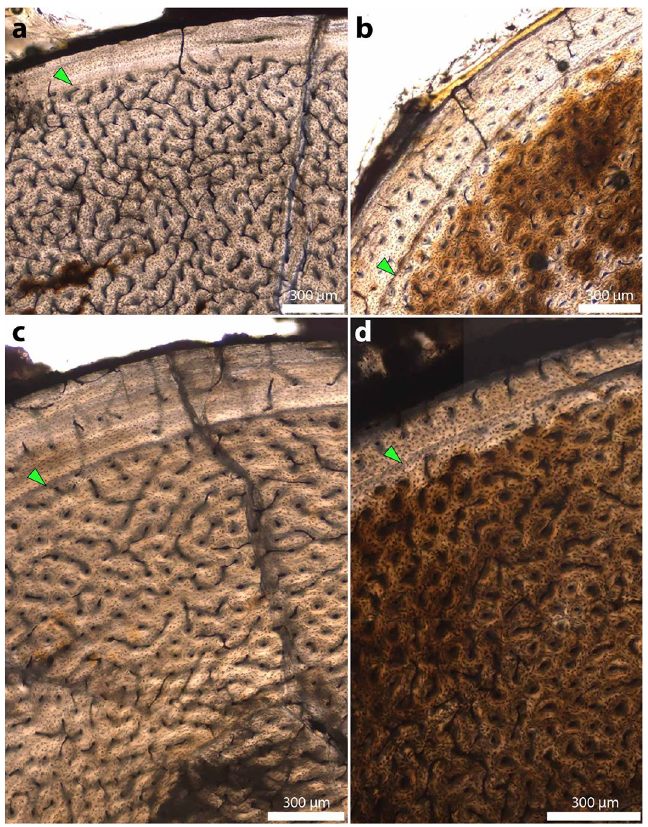
Figure 3. Cortices of Coelophysis bauri tibiae show evidence of slowed growth in individuals from different age classes. ( a ) YPM VP 41197, showing an abrupt transition from woven bone to parallel-fibered or lamellar bone in the outermost cortex. b AMNH FARB 7238, showing reduced vascular density after a LAG in the outermost cortex. ( c ) AMNH FARB 7251, showing an abrupt transition from woven bone to parallel-fibered or lamellar bone in the outermost cortex. A possible LAG between the marked LAG and the periosteal surface was not included in our quantitative analyses because it is highly localized to this portion of the tibia. ( d ) MCZ VPRA (Harvard Museum of Comparative Zoology Vertebrate Paleontology collection) 4332, showing reduced vascular density after a LAG in the outermost cortex, ( a , c ) are from four- and three-year-old individuals, respectively (based on maximum growth mark count), ( b , d ) are from one-year-old individuals. [Photo credit for d : Museum of Comparative Zoology, Harvard University, © President and Fellows of Harvard